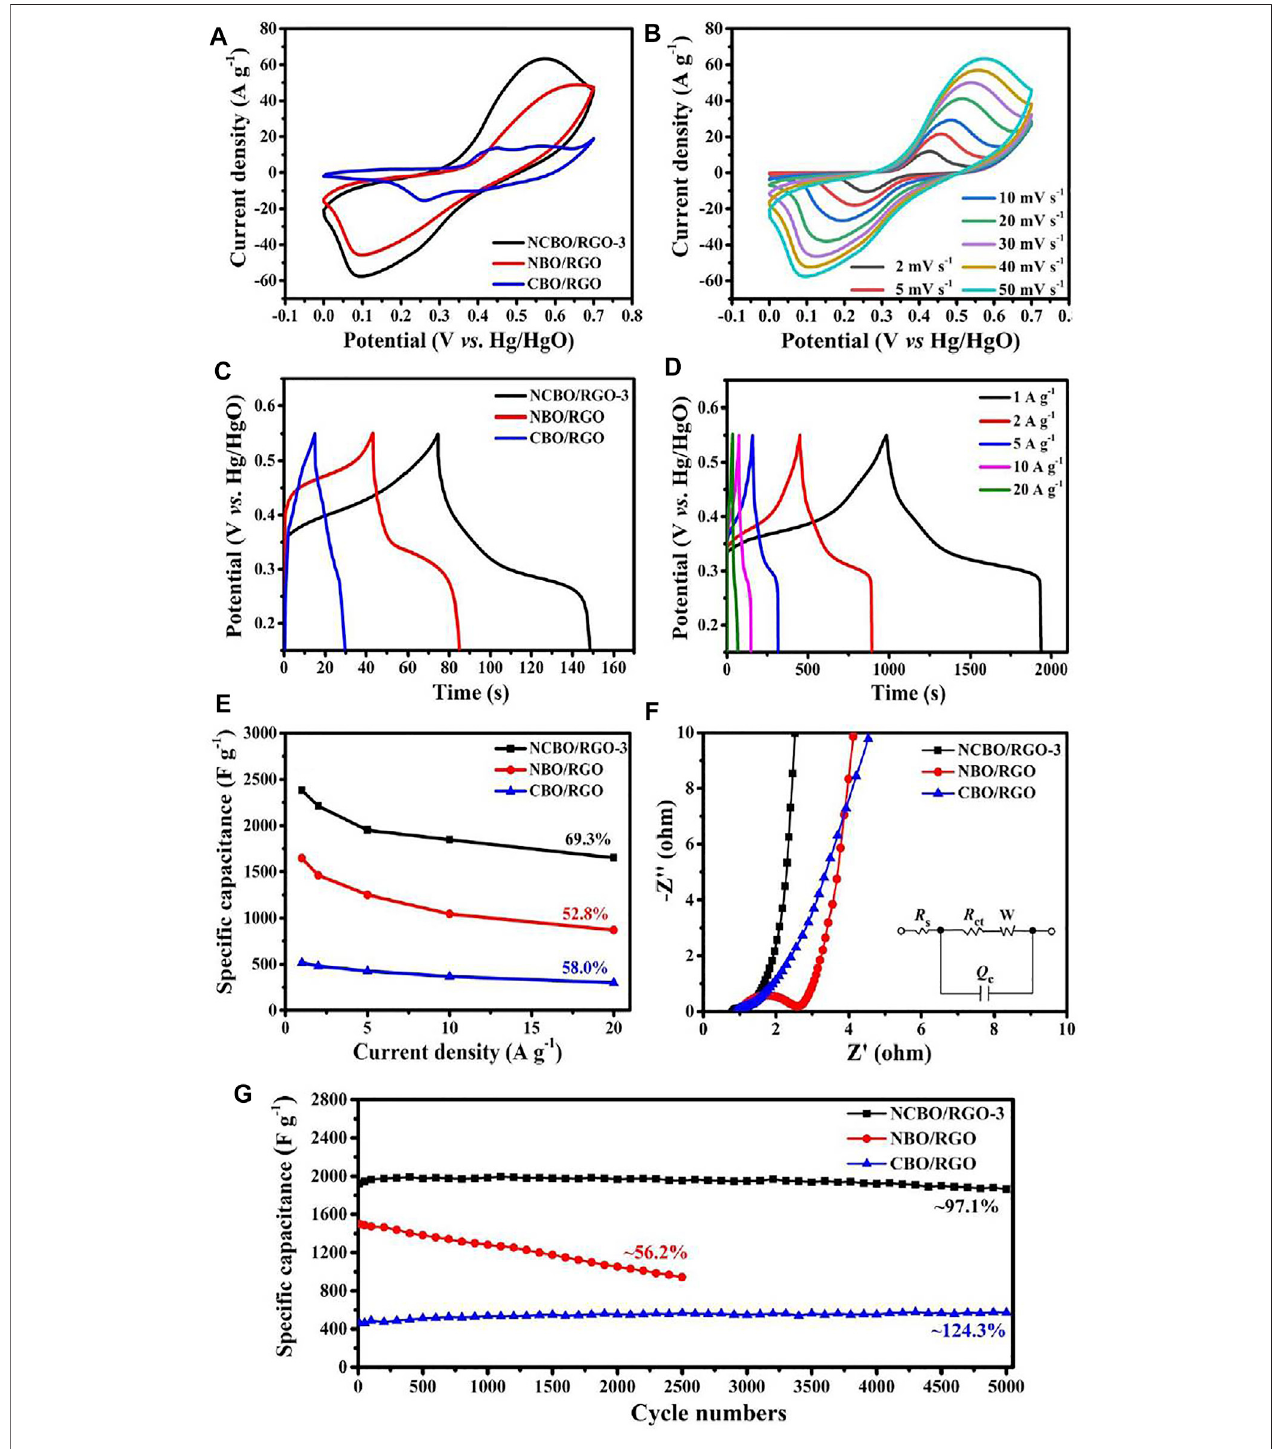
FIGURE 5 | (A) CV curves of the three TMBO/RGO samples at 50 mV s − 1 ; (B) CV curves of NCBO/RGO-3 at various scan rates; (C) GCD curves of the three TMBO/RGO samples at the current density of 10 A g − 1 ; (D) GCD curves of NCBO/RGO-3 at different current densities; (E) Speci fi c capacitances of the three TMBO/ RGO samples at different current densities; (F) Nyquist plots of the three TMBO/RGO samples; (G) Cycling performances of the three TMBO/RGO samples at 5 A g − 1 .